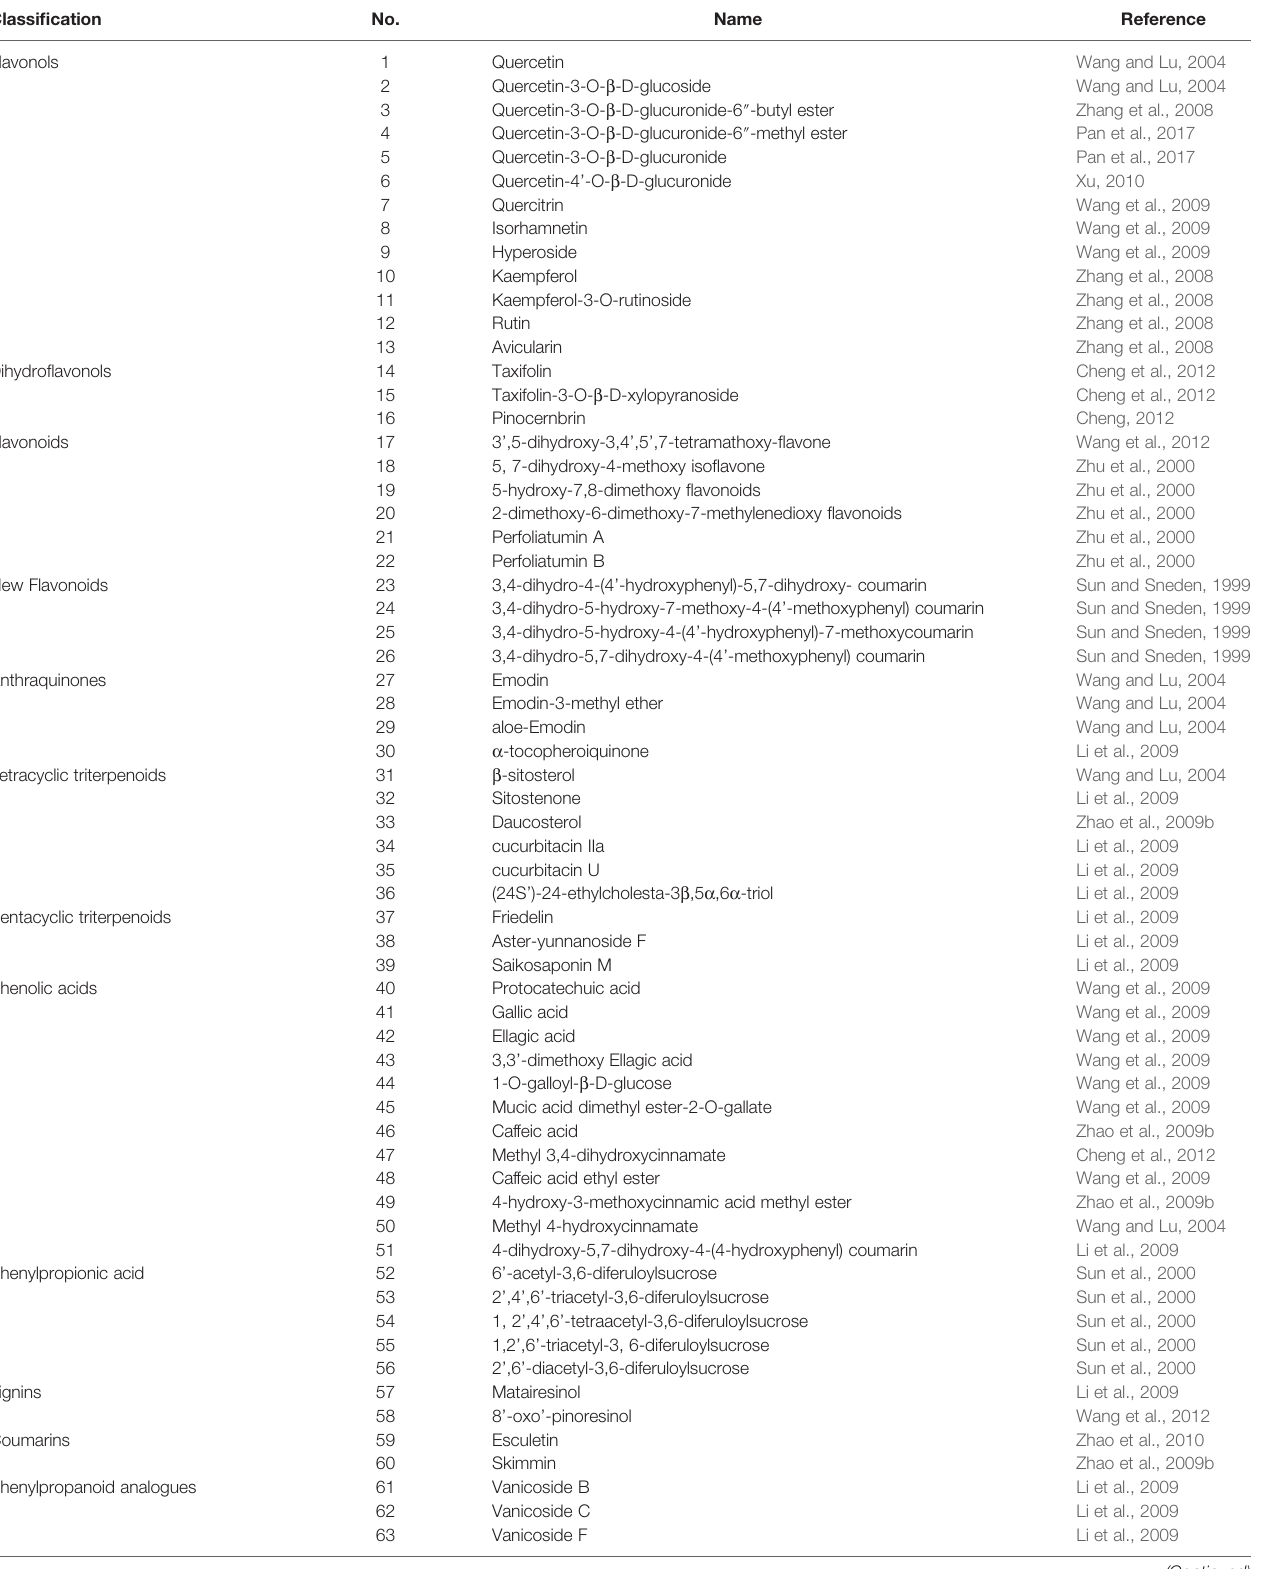
TABLE 1 | Chemical constituents of fl avonoids from Polygonum perfoliatum